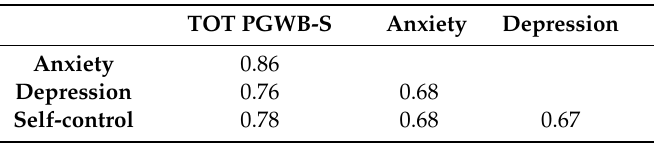
Table A1. Scale -level correlation matrix with the Psychological General Well Being Index (PGWB) anxiety, depression, self-control scales and the total score of the short form of the Psychological General Well Being Index PGWB-S considering our